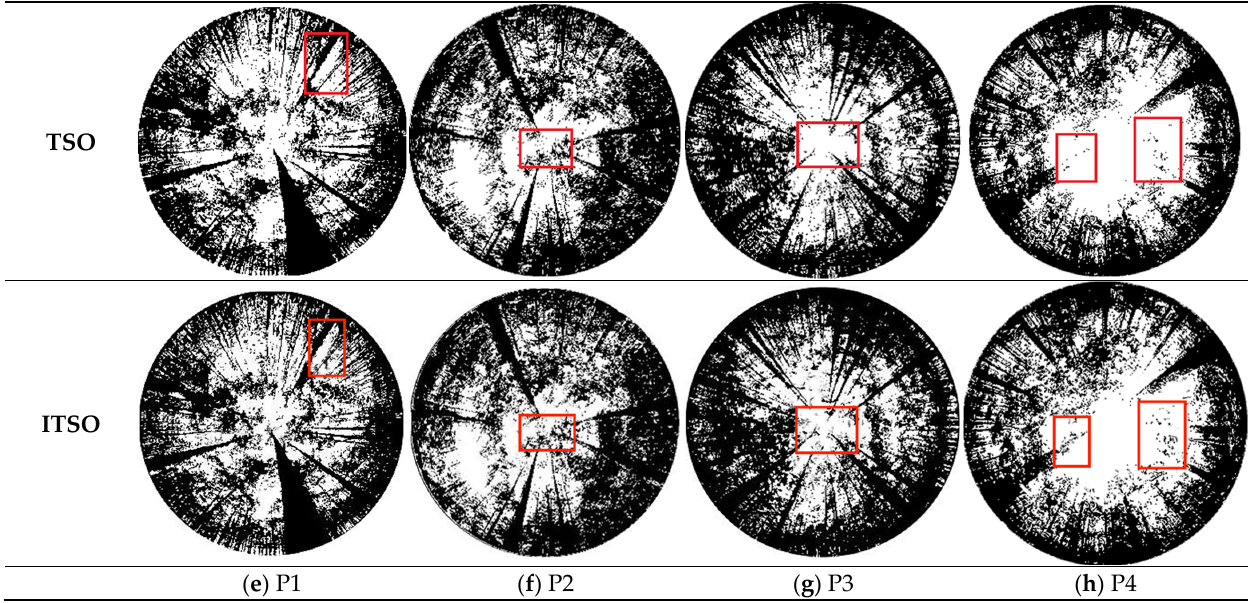
Figure 5. Results of image segmentation.